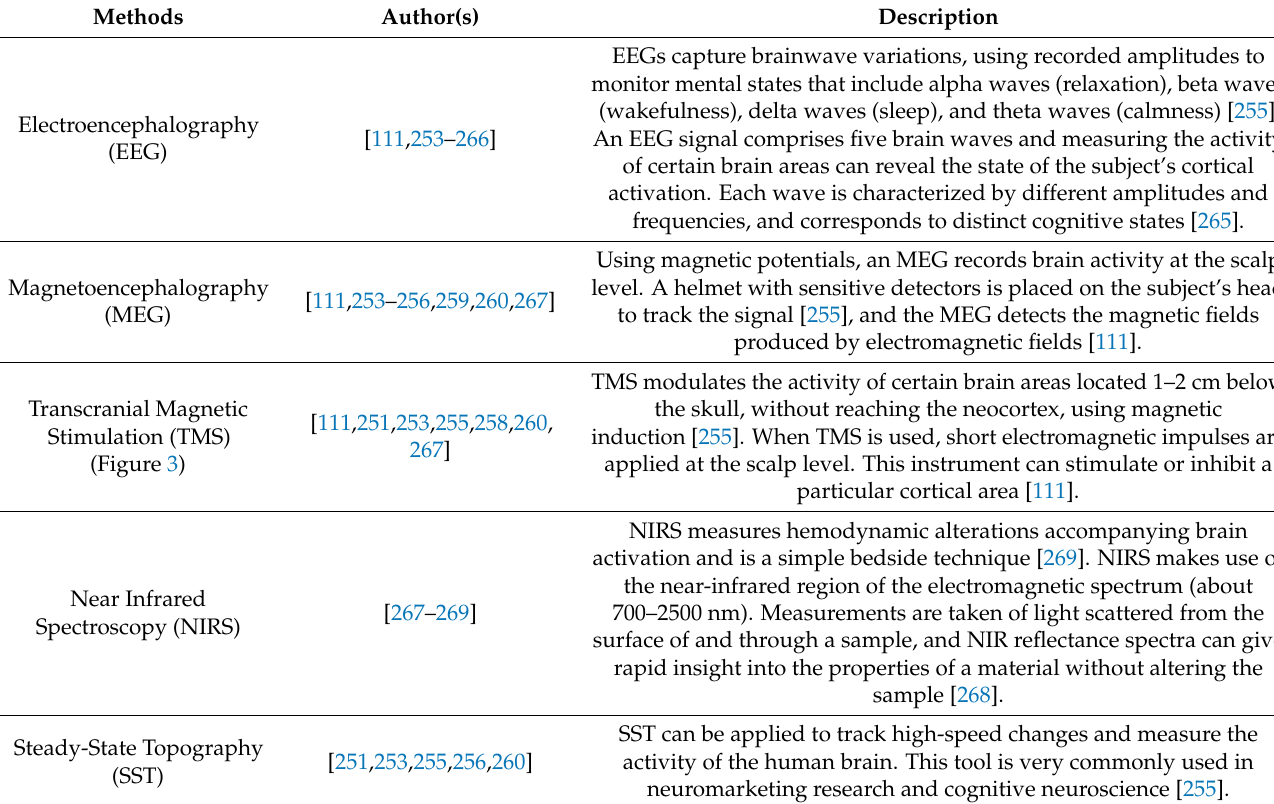
Table 1 demonstrates traditional non-invasive neuroscience methods. Table 1. Traditional non-invasive neuroscience